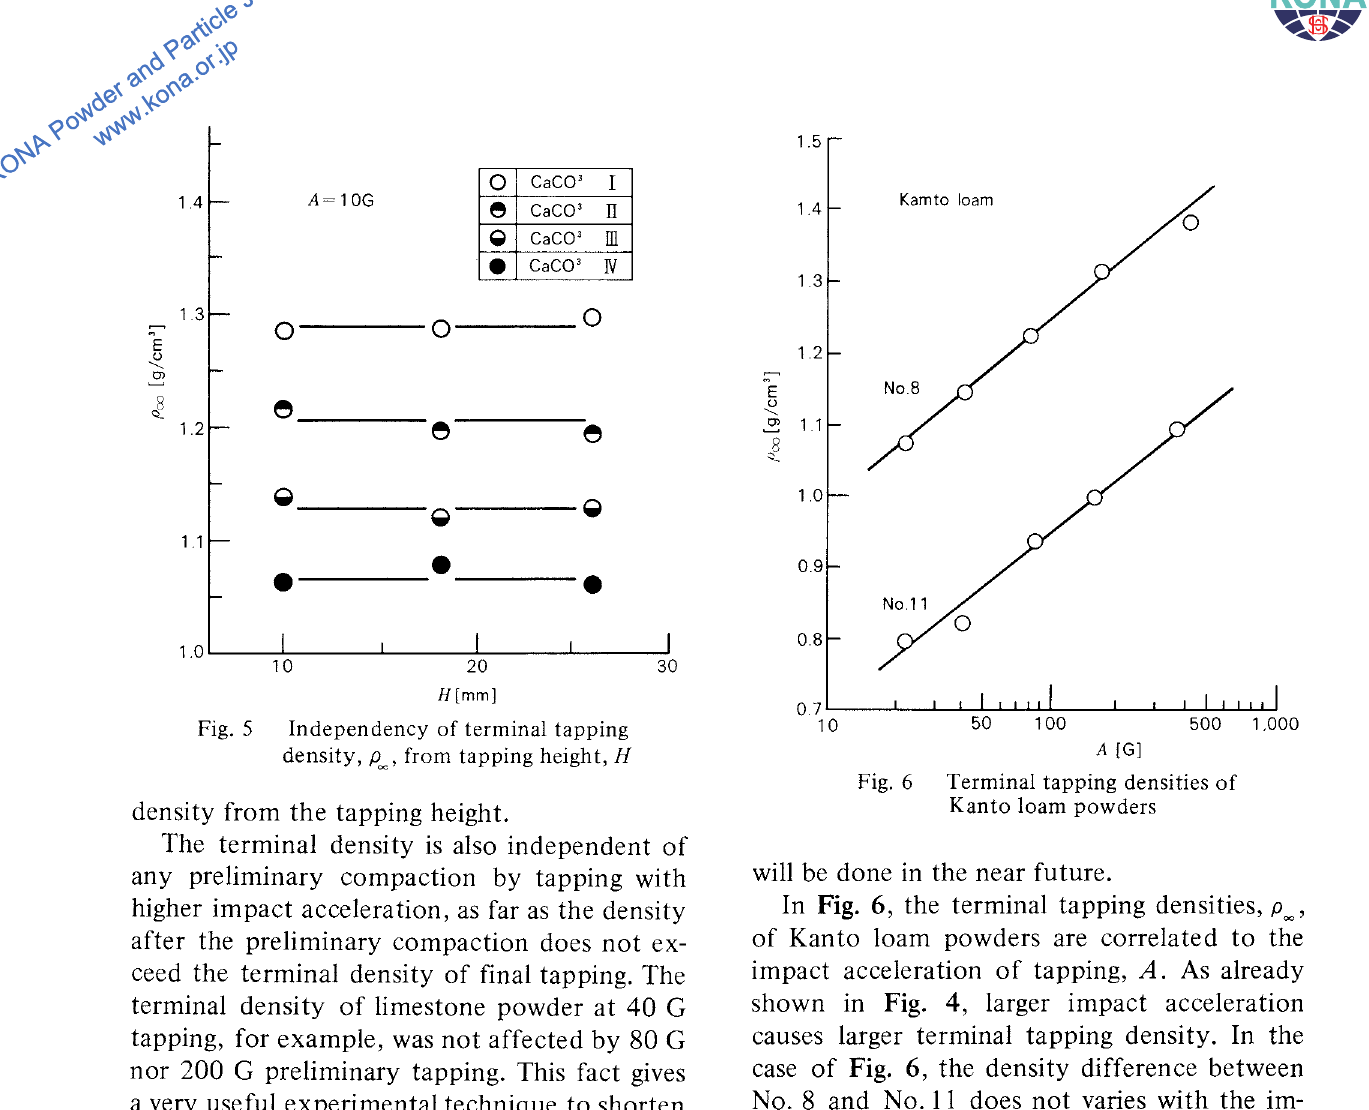
Fig. 5 Independency of terminal tapping density, p=' from tapping height, H